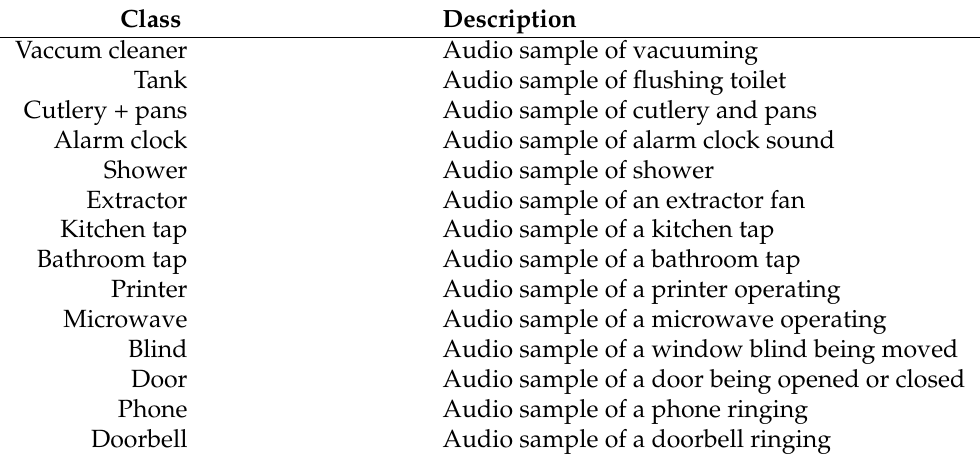
Table 2. Sound events and descriptions developed in the context of daily